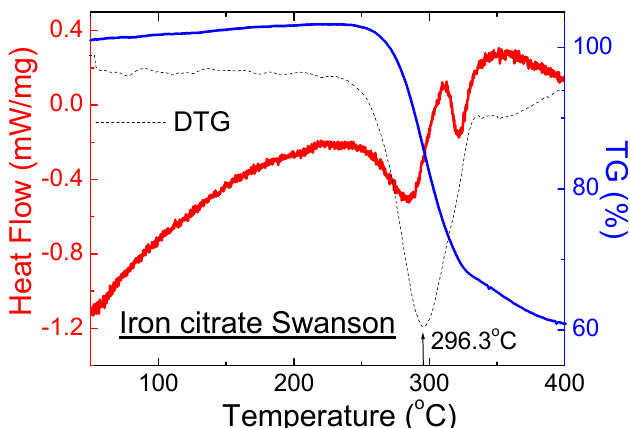
Figure 12. DSC and TG/DTG curves of a dietary supplement containing iron citrate: Iron citrate Swanson.